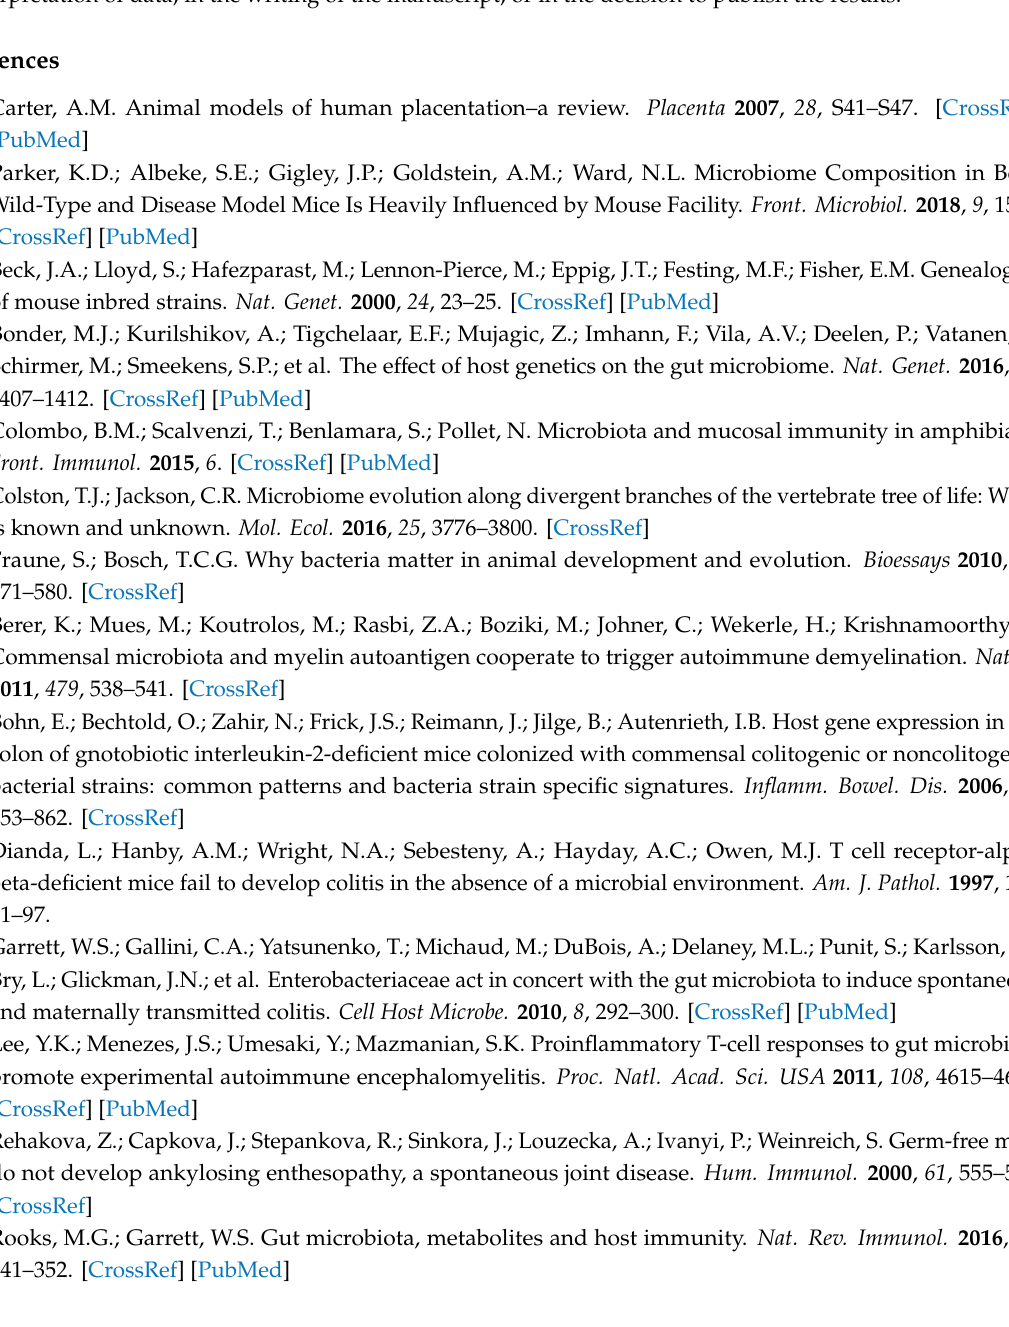
Table S1: Wilcoxon rank-sum tests of di ff erences in Chao1 index and Shannon index across di ff erent sampling locations, genotypes or vendors. Table S2: Pairwise ANOSIM results on the Bray–Curtis distance matrix across di ff erent sampling locations, genotypes or vendors with 999